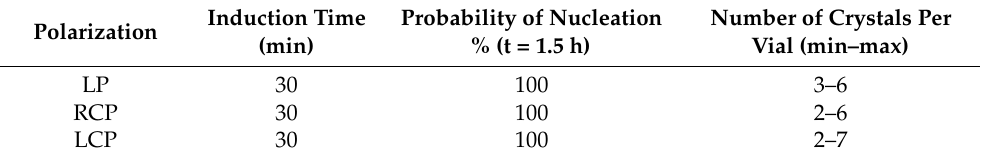
Table 2. Influence of the type of polarization on the nucleation behavior of K 2 SO 4 solutions at β = 1.25: LP (linear polarization), RCP (right circular polarization), and LCP (left circular polarization).